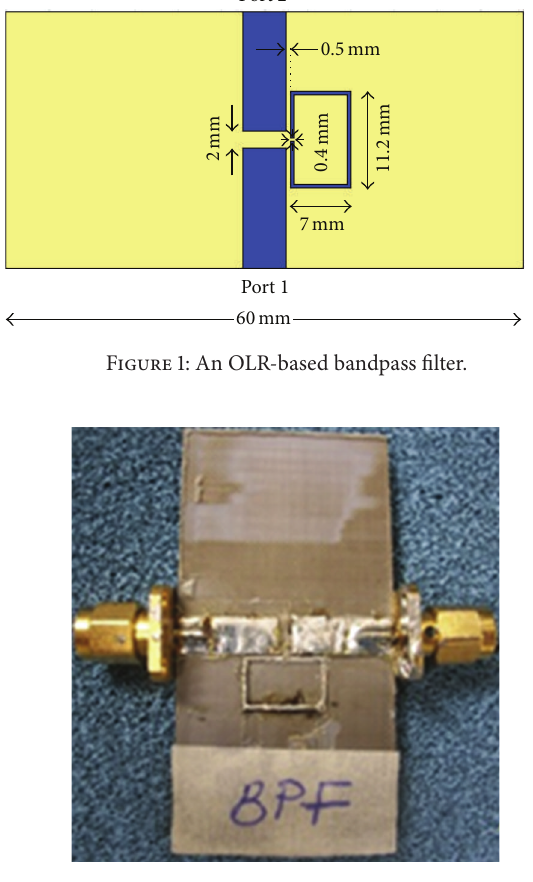
Figure 2: A photo of the fabricated bandpass filter